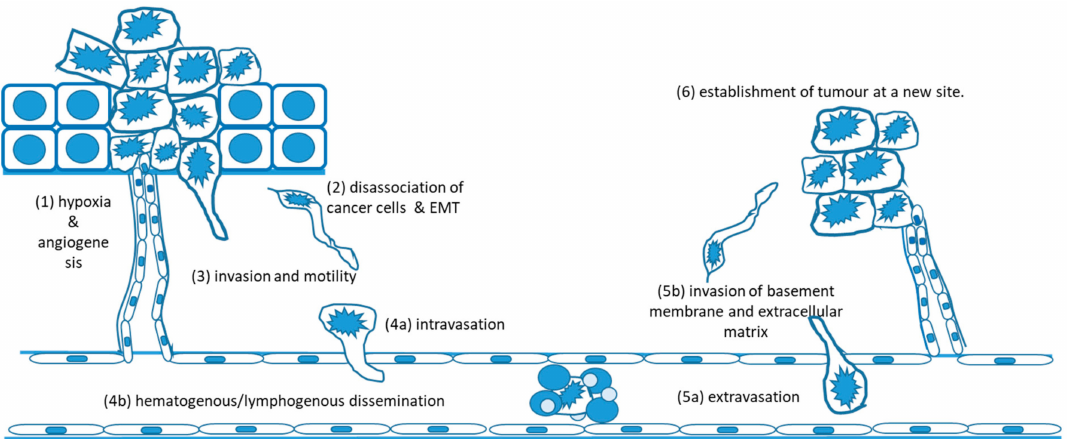
Figure 1. The metastatic cascade: (1) hypoxia in the growing tumour stimulates new blood vessel formation (angiogenesis) to supply the tumour with oxygen and nutrients and remove waste